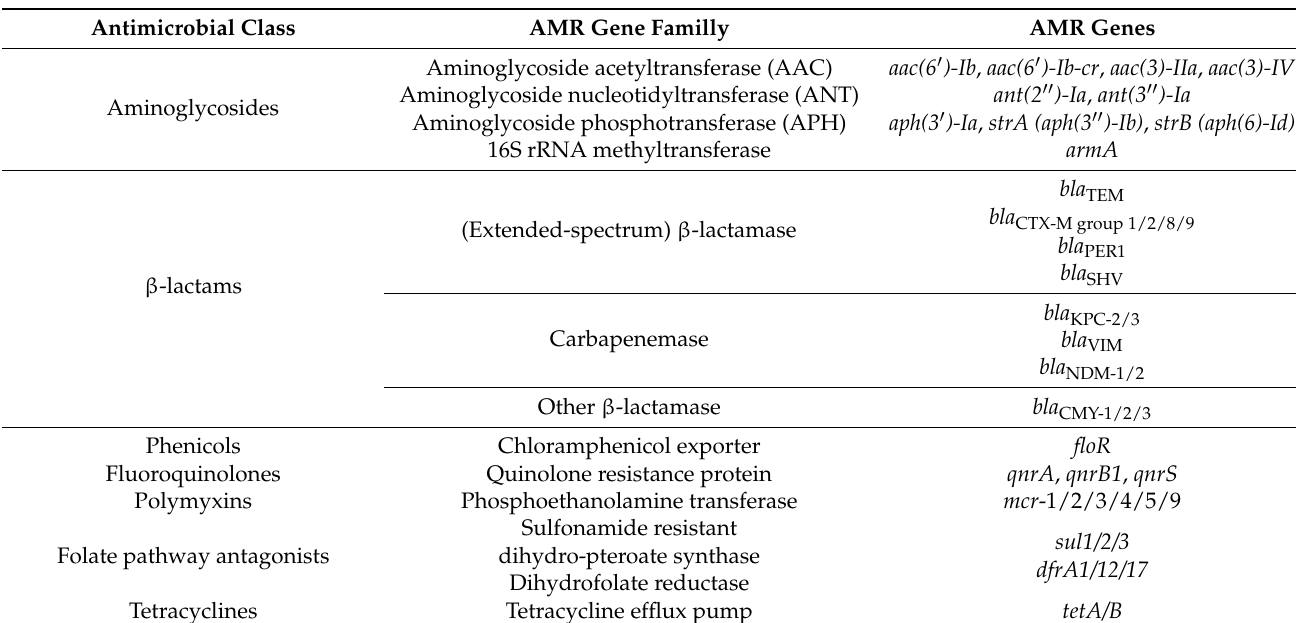
Table 1. Antimicrobial resistance genes (ARGs) selected for the AMR–Array design.